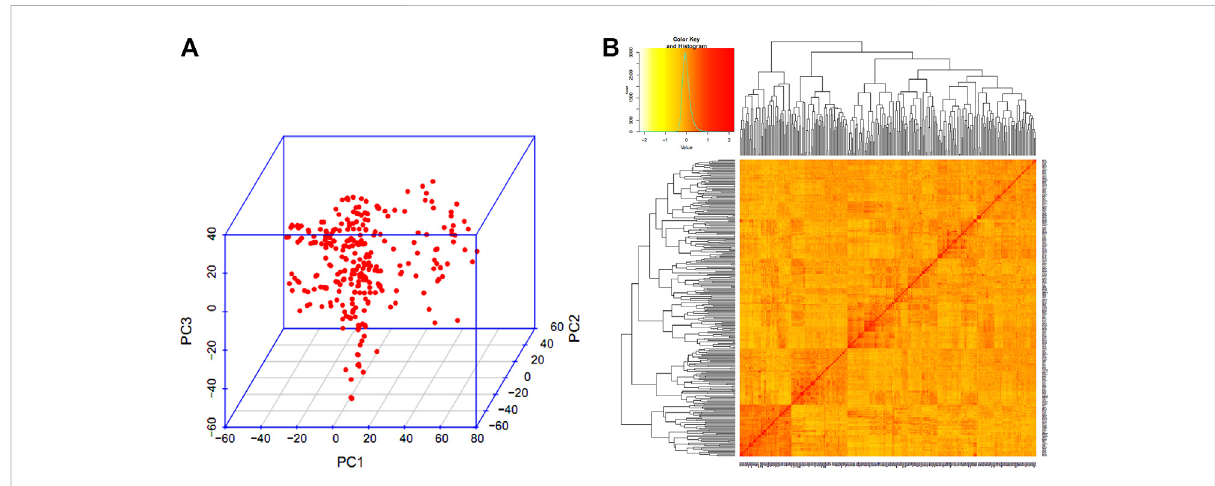
FIGURE 3 Population structure of GWAS panel. (A) Three-dimensional plot of the fi rst three principal components. (B) Heat map of pair-wise kinship